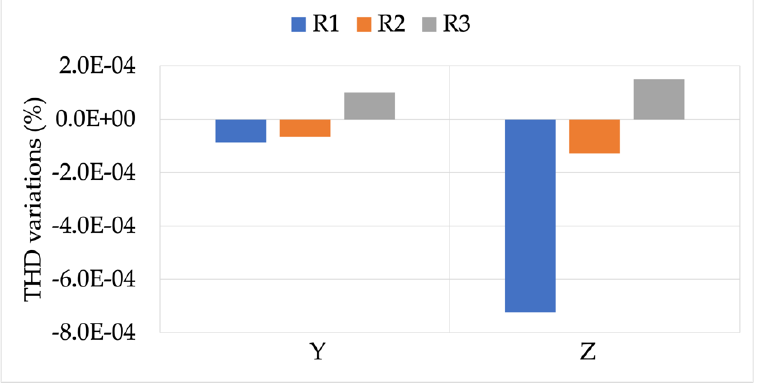
Sensors 2022 , 22 , x FOR PEER REVIEW Figure 12. THD variations, compared to position L, obtained from measurements at the position O. Figure 12. THD variations, compared to position L, obtained from measurements at the position O. Figure 12. THD variations, compared to position L, obtained from measurements at the position O.